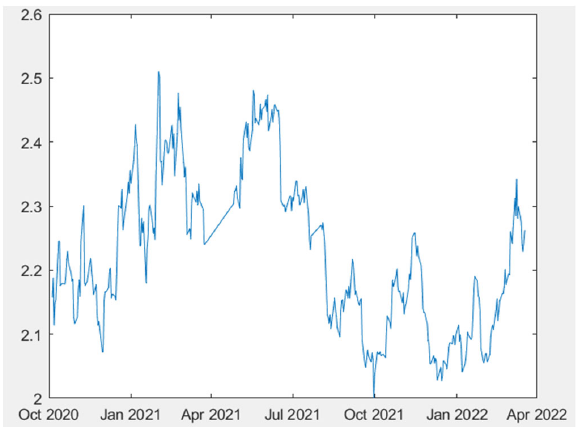
Fig. 3. Silver Price Data Chart